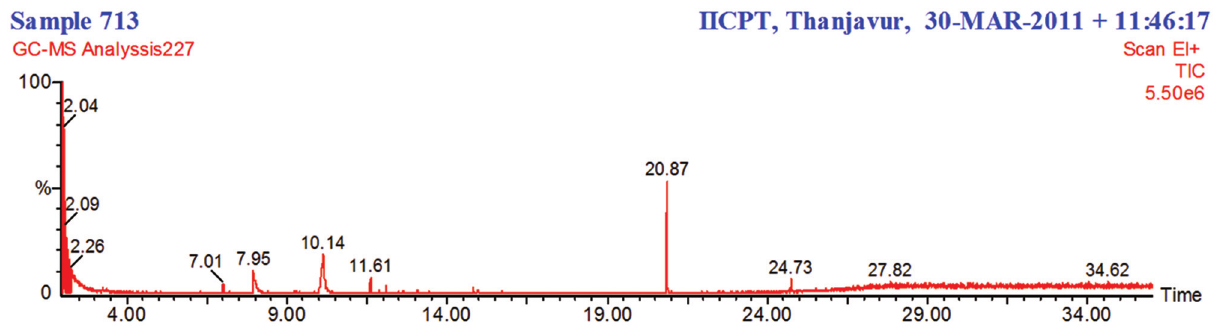
Figure-1: Gas chromatography-mass spectrometry chromatogram of the ethanolic extract of Indigofera tinctoria